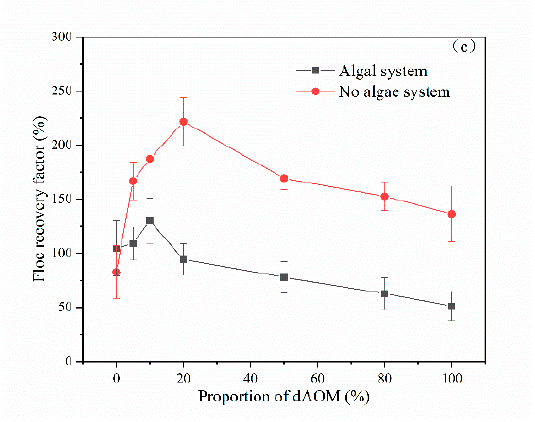
Figure 2. Stable floc size ( a ), strength factor ( b ), and recovery factor ( c ) of MC in algal and non-algal systems at different dAOM concentrations.